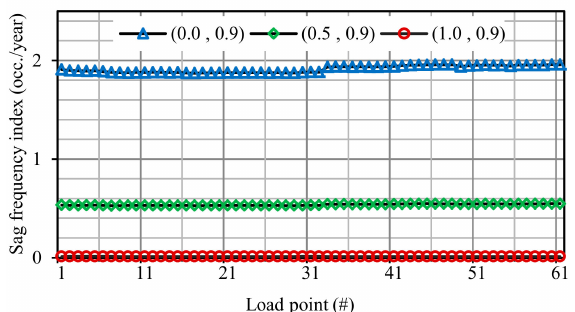
Figure 10. SFI with three di ff erent time duration thresholds associated with load points in the network.